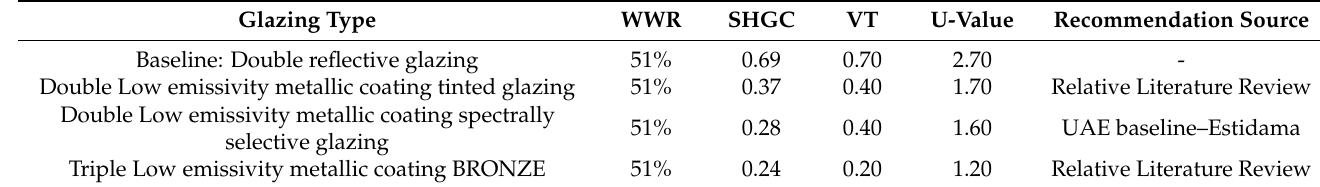
Table 7. Glazing types for simulation details and